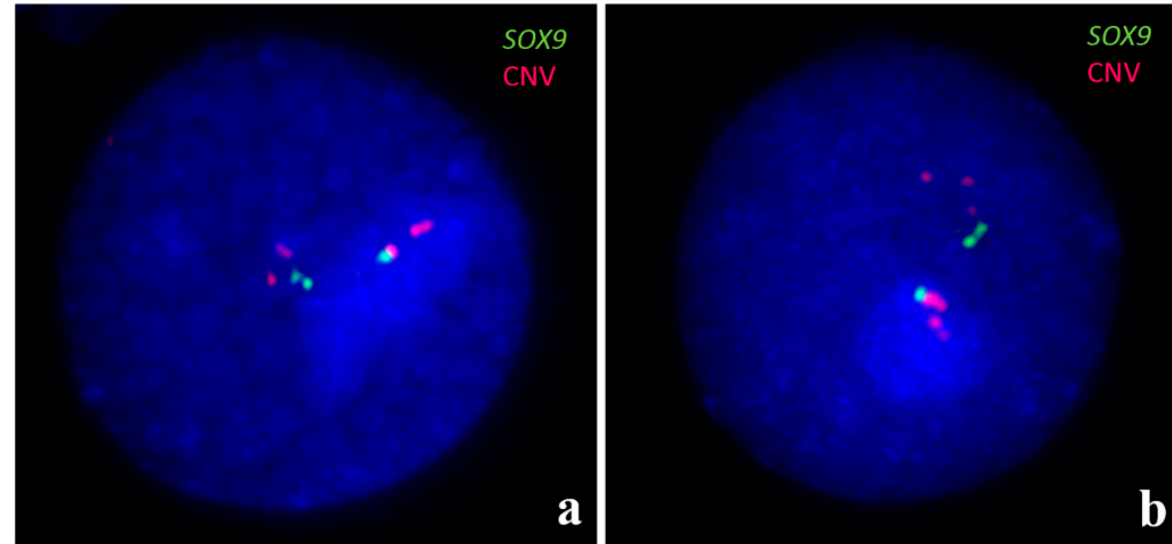
Figure 5. FISH for identification of three copies of SOX9 gene (green signals) in two interphase nuclei ( a , b ). Moreover, multiple copies at CNV region upstream SOX9 , as well as homologous region of CFA18 (red signals), are visible. For details, see [64].